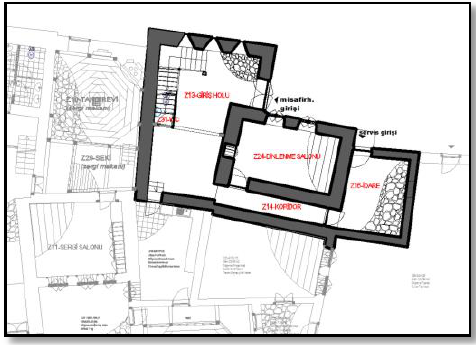
Figure 16. Restoration Project- Spaces of Cafeteria Section